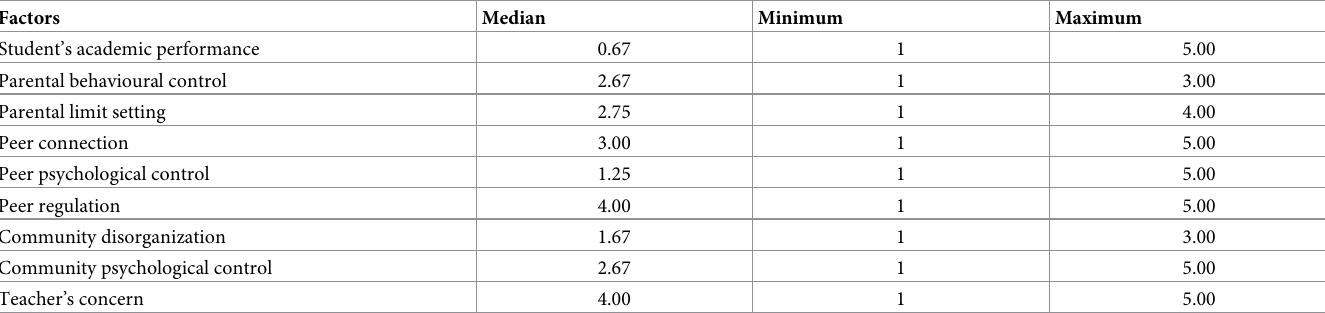
Table 2. Descriptive statistics of contextual